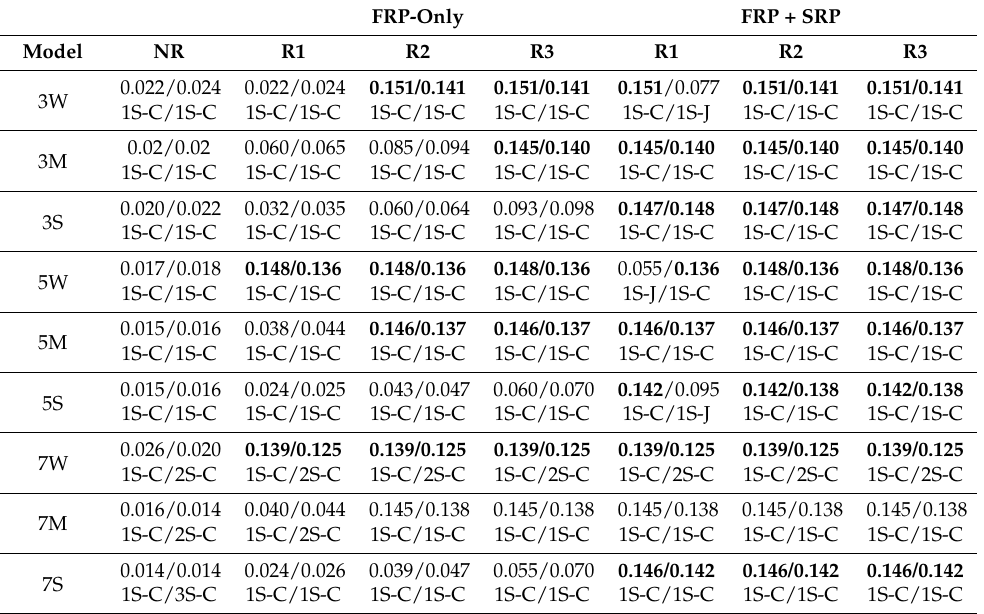
Table 1. PGA c,SLV (g) for the archetype buildings with W, M and S infills configurations and for mass/mode analyses. No retrofit NR and R1, R2 R3 increasing retrofit levels are considered for FRP-only and FRP + SRP retrofit solutions. nS-C and nS-J indicates column failure (brittle or ductile) or joint failure at the nth storey, respectively.